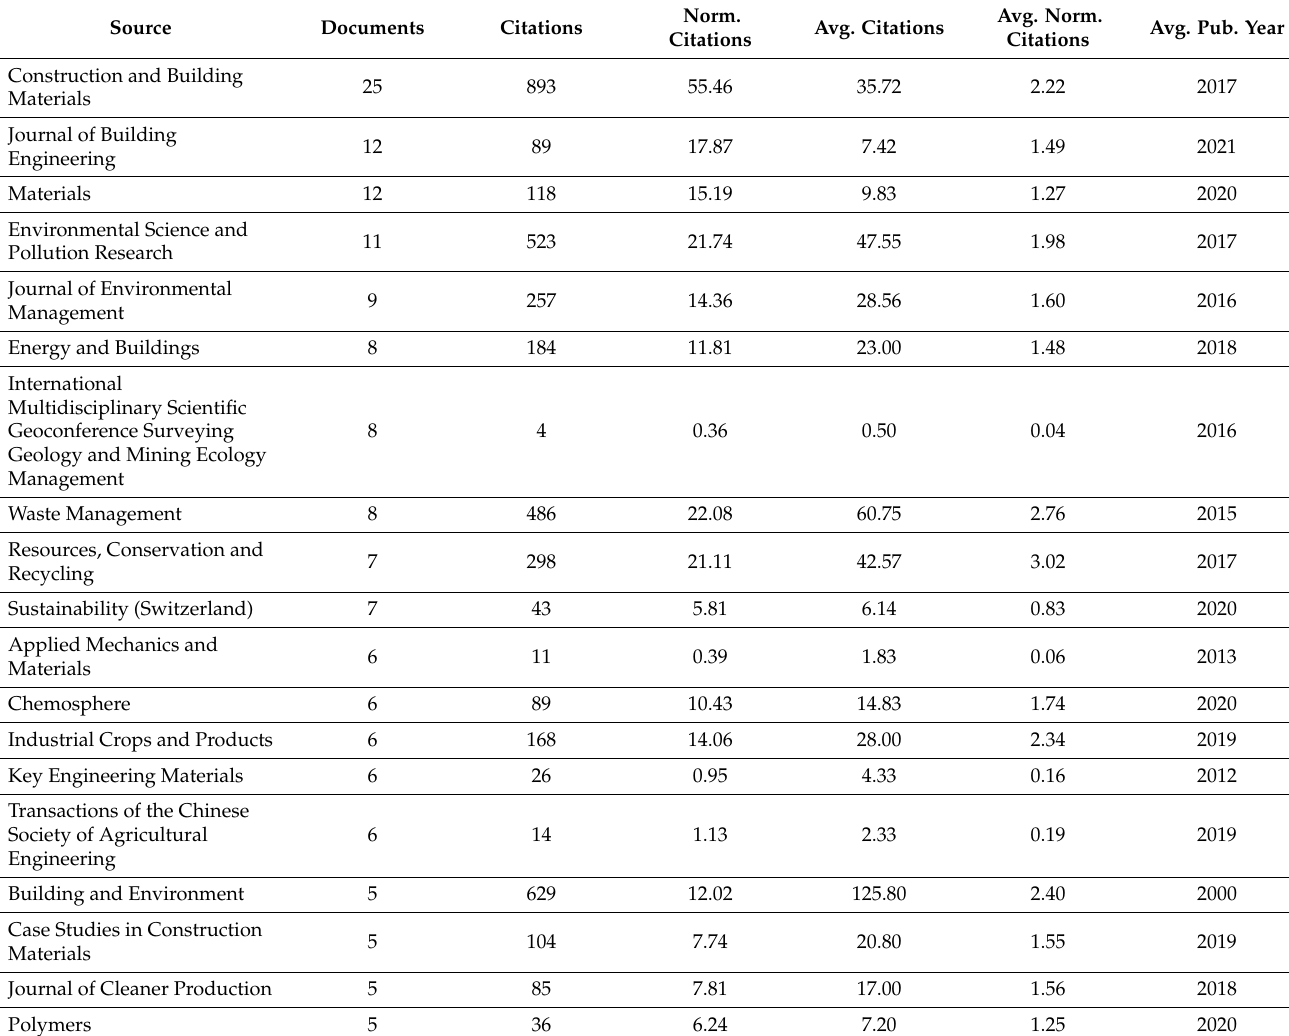
Table 3 provides a quantitative summary of the impact of the sources. Table 3. Quantitative summary of impact of